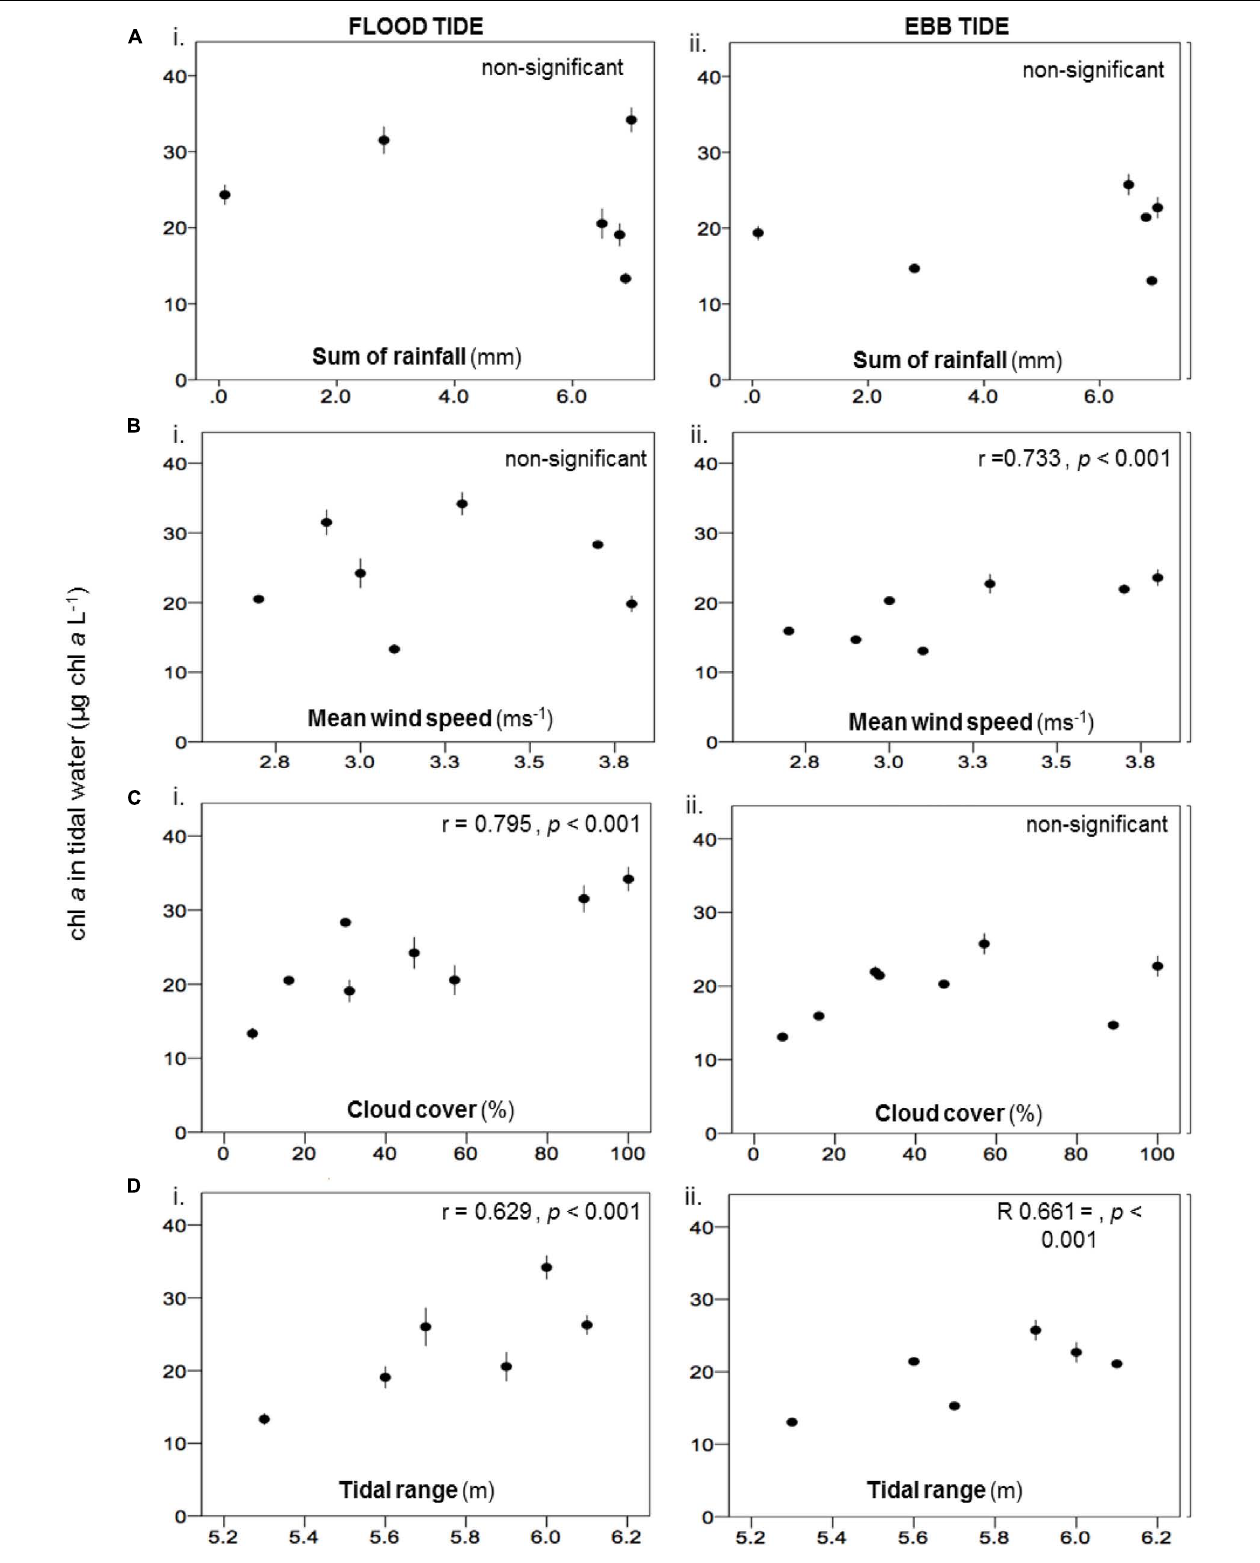
FIGURE 6 | Relationship between water column Chl. a concentration (mean ± SE, n = 3) in (i) flood and (ii) ebb-tide water over the salt marsh with (A) sum of rainfall for 3 days; (B) averaged wind speed for 3 days; (C) percentage of cloud cover; and (D) the tidal range, during spring tides at Fingringhoe Wick, Colne Estuary, Essex, United Kingdom, in August and September 2015.